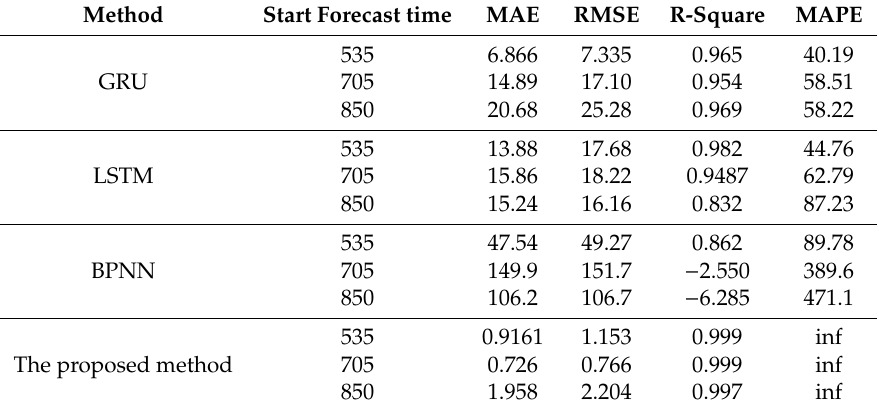
Table 3. Performance comparison of four prognostic methods at di ff erent